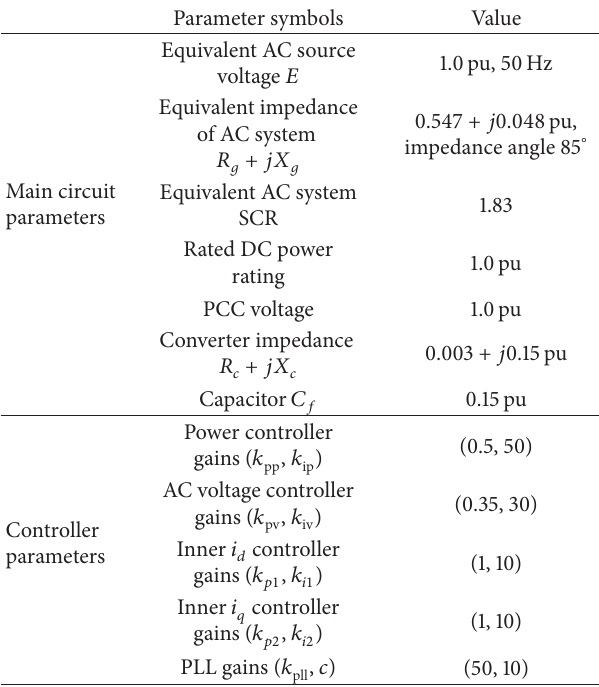
Table 1: Parameters of VSC connected to weak AC